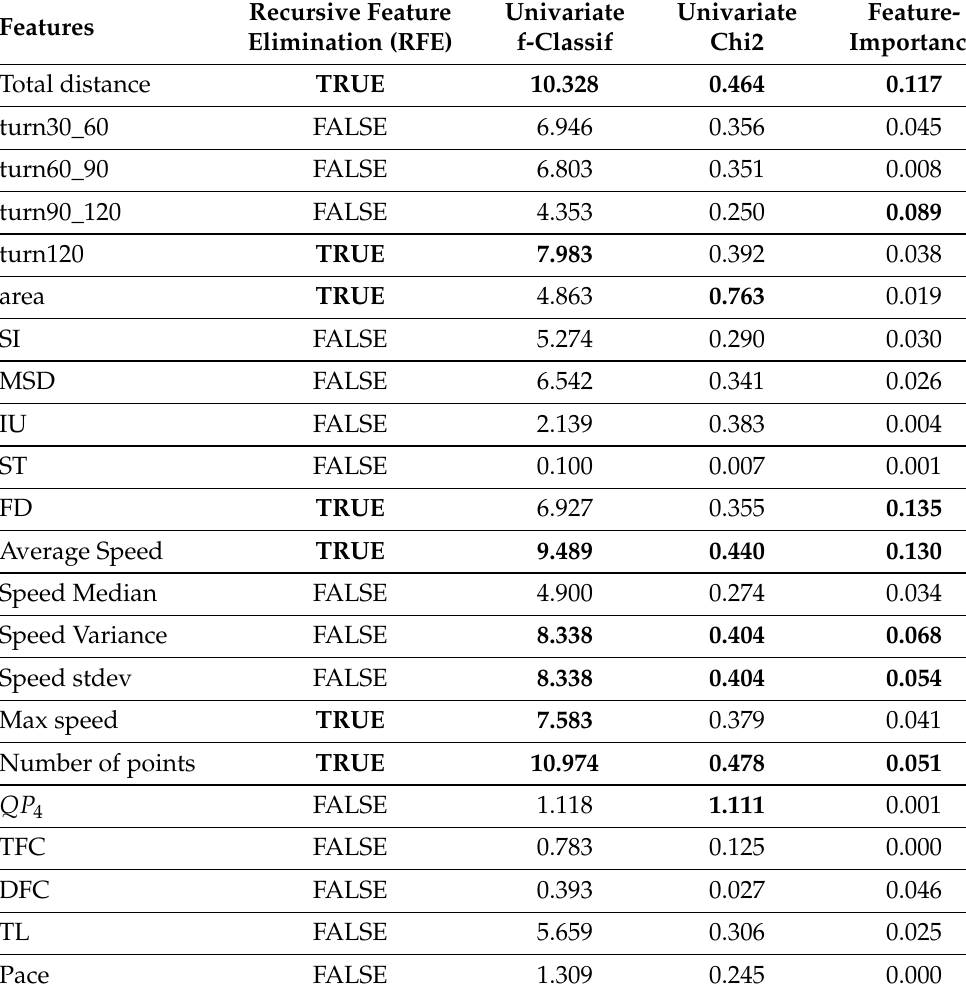
Table A6. Features-Selection methods weight results. Selected features marked in bold.